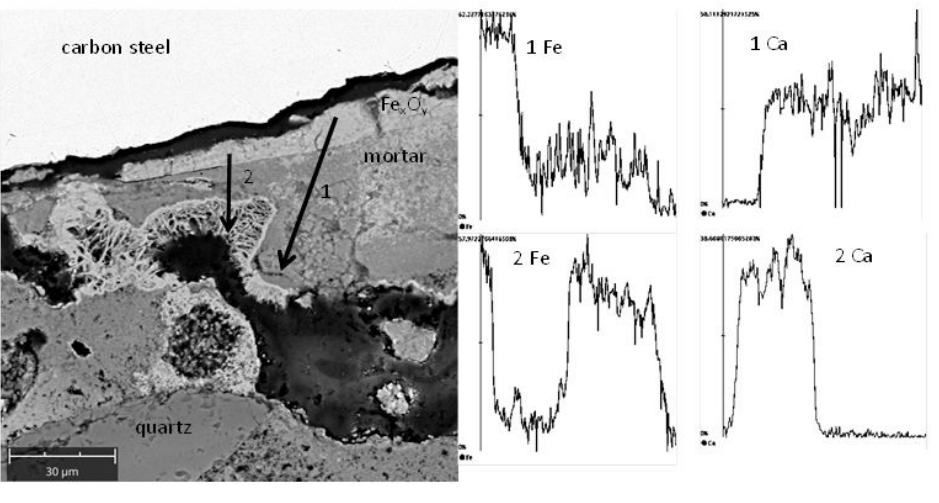
Figure 2. Interface between carbon steel and lime mortar. The arrows indicate line scans 1 and 2.